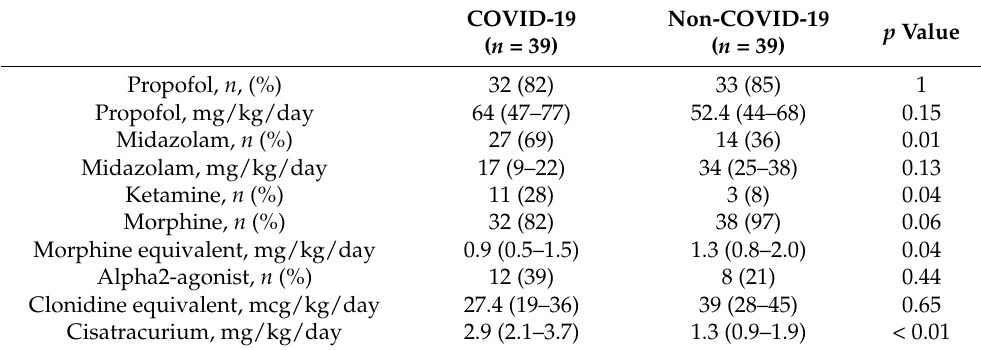
Figure 3. Distribution of sedative use according to ARDS COVID-19 versus non-COVID-19 ARDS. Table 3. Drug consumption. Data are expressed as counts (percentage) and median (interquartile range). Legend: NMBA = Neuromuscular blocking agents.